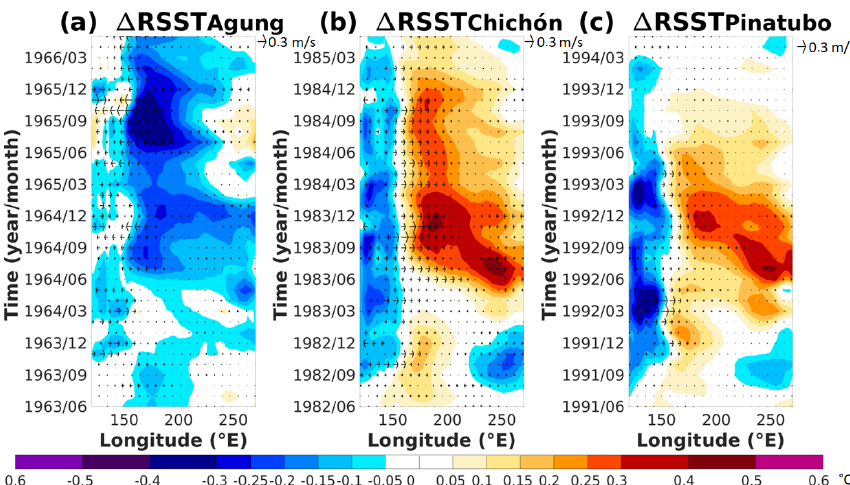
Figure 3. Hovmöller plot of the ensemble mean of the relative SST anomalies in the equatorial Pacific (averaged over − 5 and 5 ◦ N) and the change in the zonal component of the 10m winds (m/s) for the 3 years following each eruption. The anomalies are calculated relative to the 3 years before each eruption.